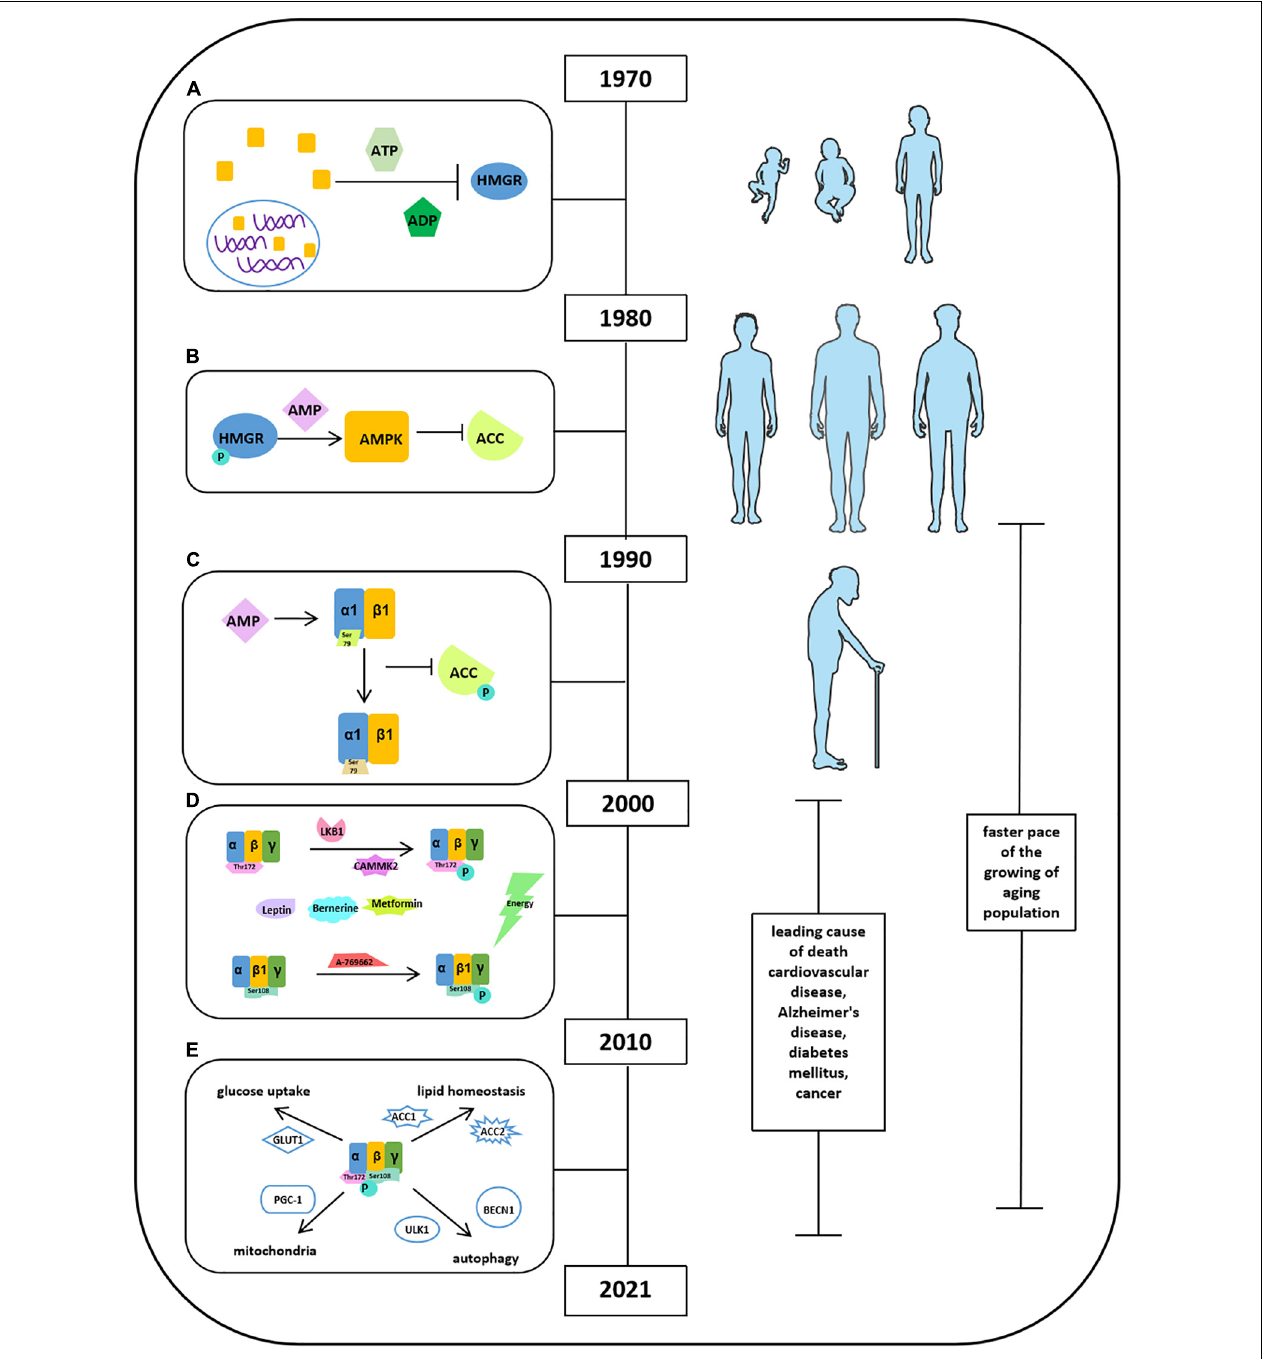
FIGURE 1 | Milestones of discoveries of AMPK protein. (A) Cytosolic factor could inactivate 3-hydroxy-3-methyl-glutaryl-coenzyme A reductase (HMGR) in the presence of ATP and ADP. (B) ACC and HMGR could be purified separately, and the ACC and HMGR are regulated by AMP. (C) The structure of AMPK comprised an α 1 catalytic subunit with a functional domain and a β 1 subunit. AMPK is allosterically activated by AMP to phosphorylate and inactivate ACC at Ser79. (D) Factors reported to stimulate AMPK activation. (E) Activities of AMPK in glucose uptake, lipid homeostasis, autophagy, and mitochondria.